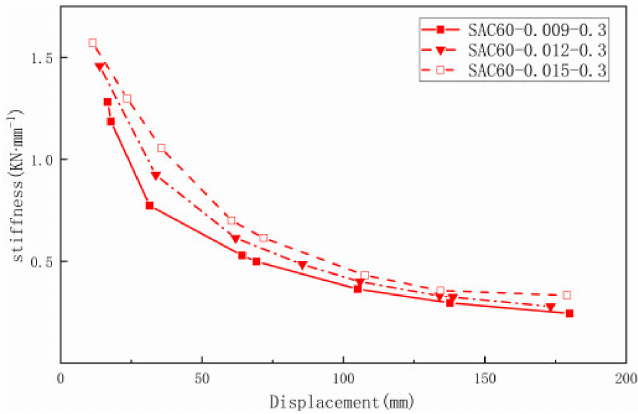
Figure 16. Relationship between stiffness degradation and